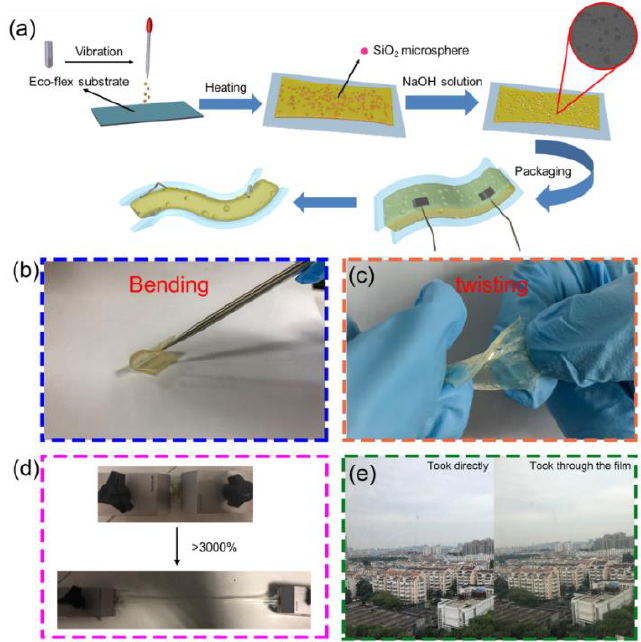
Figure 1. ( a ). The schematic illustration of the fabrication process of the ionogels. ( b ) The photograph of ionogels bending. ( c ) The photograph of ionogels twisting. ( d ) The photograph of ionogels stretching. ( e ) The photograph of ionogel film using the laboratory outside as the background.